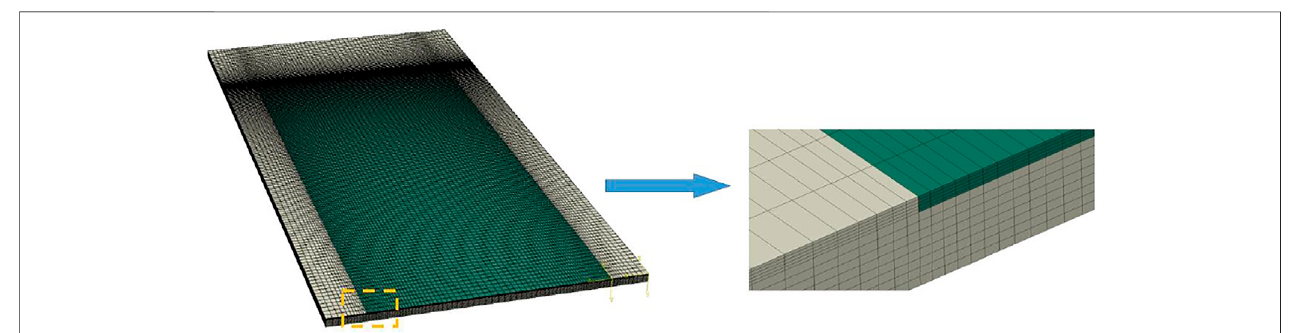
FIGURE 6 | Finite element